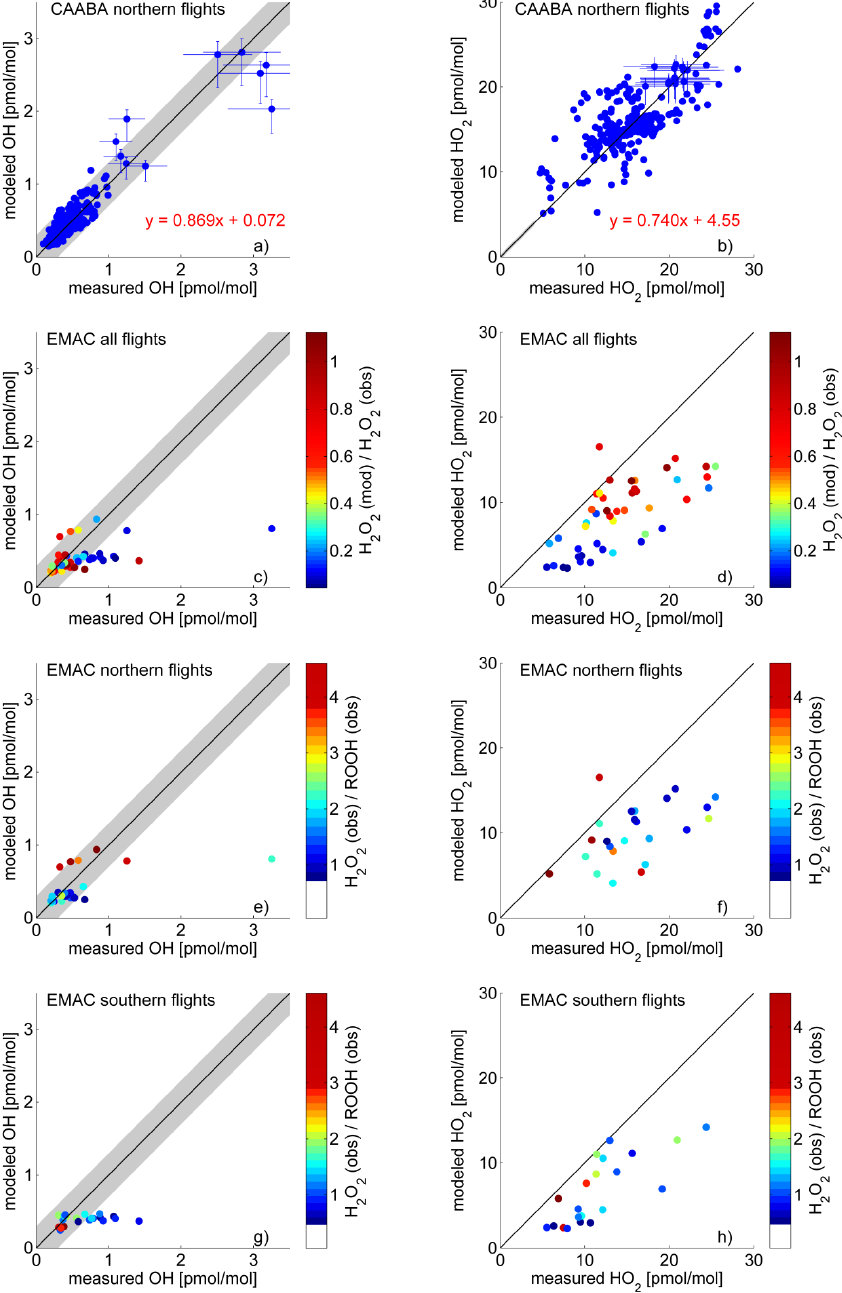
Figure 9: Comparison of model calculations to observed OH and HO 2 . CAABA reproduces the observed OH mixing ratios within ± 0.3 pmol/mol (shaded area) in the upper troposphere. The 1:1 line is given in black, the equation given in red indicates the result of a linear fit. In subplots a) and b) a limited number of errorbars is shown to improve readability.